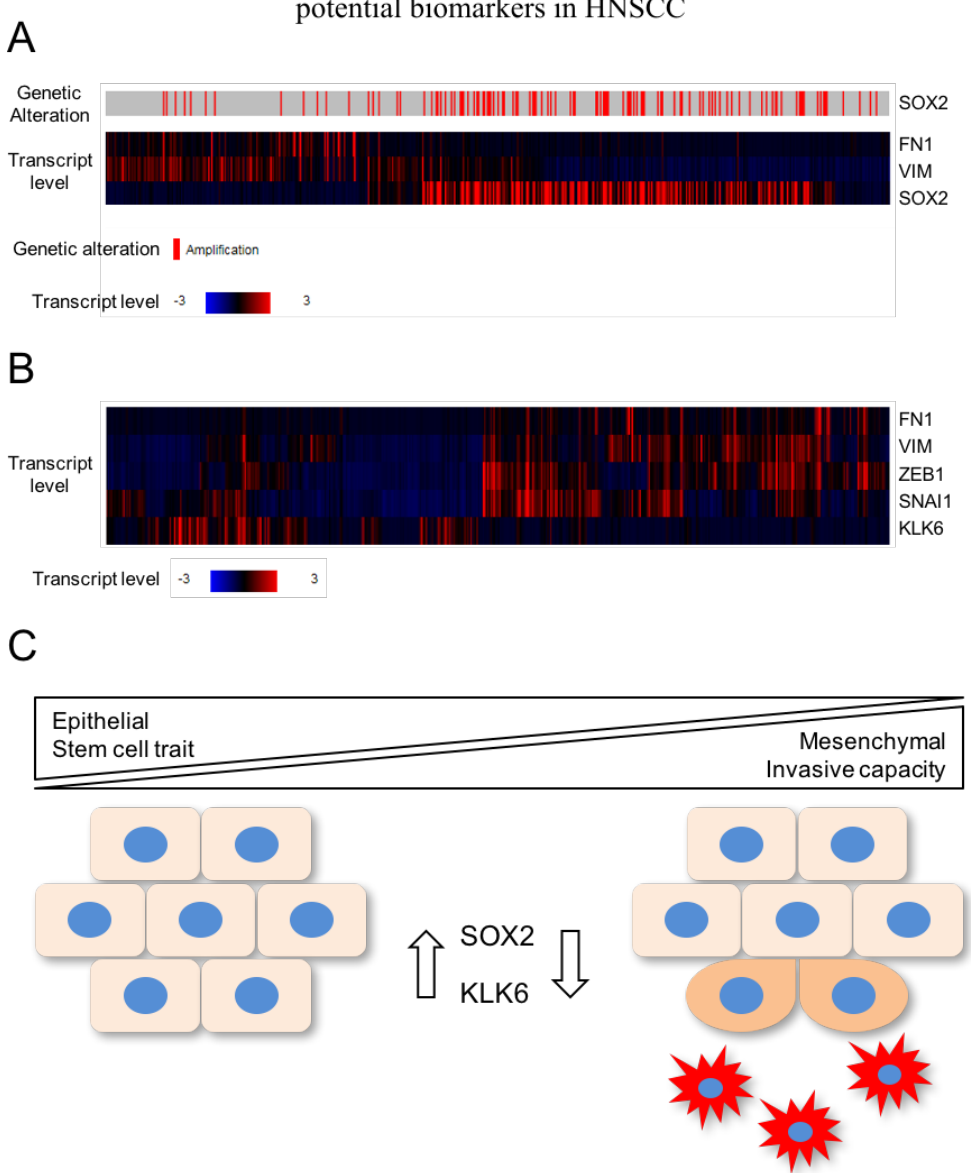
Figure 2. ( A ) Several well-established mesenchymal marker genes (e.g., VIM and FN1) are